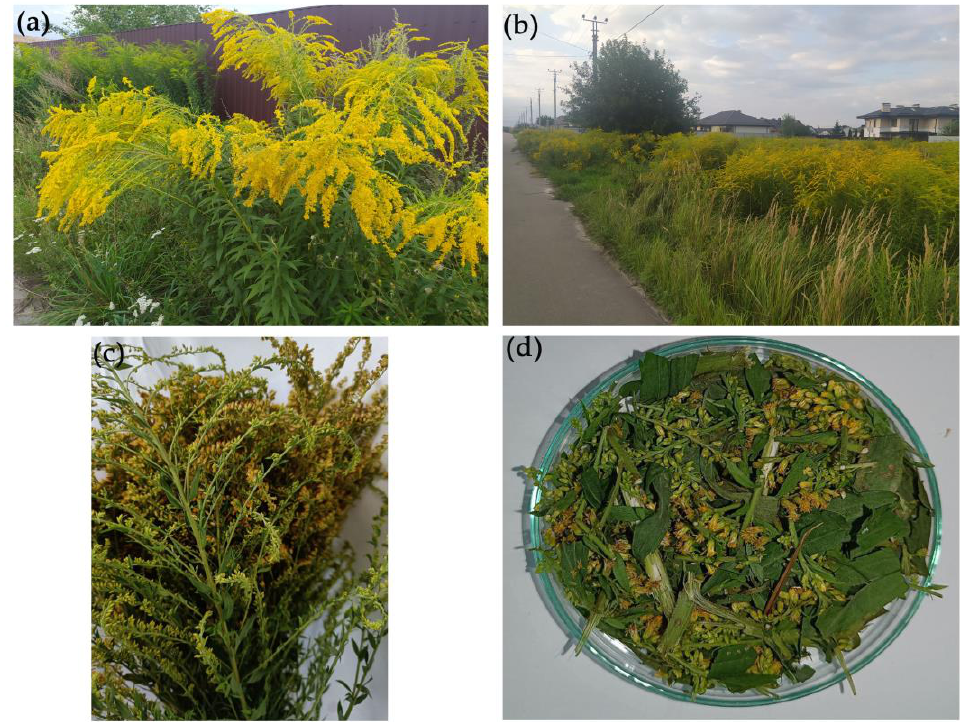
Figure 1. The spread of Solidago canadensis L. in the Sofiivska Borshchahivka village ( a , b ), Kyiv region, Ukraine) and drying ( c ) and the grinding ( d ) of plants for anaerobic degradation.